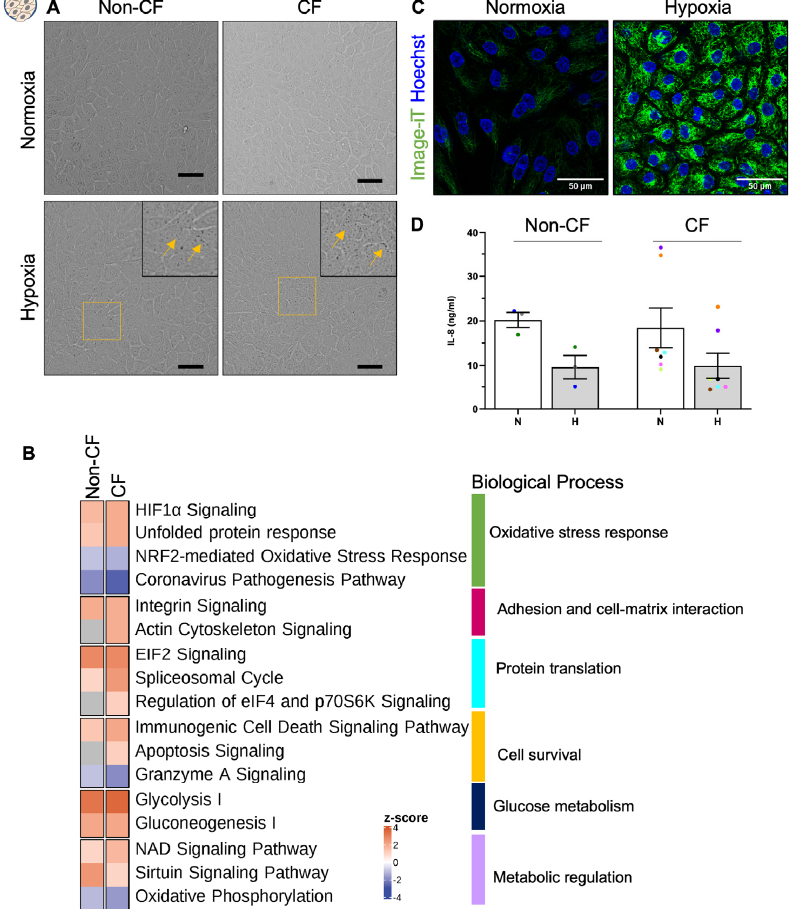
Figure 2. E ff ect of chronic hypoxia on the expansion of primary human nasal epithelial cells (hNECs). ( A ) Representative bright fi eld images of hNECs cultured at normoxia and hypoxia for 5–7 days. Magni fi ed inset with yellow arrows shows granulation. Scale bars = 50 µm. ( B ) Heatmap of enriched canonical pathways of di ff erentially expressed proteins determined by IPA. Color indi- cates the z-score for each pathway, with red (positive) indicating predicted activation, blue (nega- tive) indicating predicted inhibition, and grey indicating no enrichment. Data were derived from 3 non–CF and 8 CF participants. ( C ) Representative intracellular hypoxia imaging using Image–iT green hypoxia reagent, 63x/1.4 oil immersion objective. Scale bars = 50 µm. ( D ) IL–8 ELISA meas- urement in culture supernatants of con fl uent normoxic and hypoxic hNECs. Each colored circle represents cultures of an individual participant. Data are presented as bar plots with mean ± stand- ard error of the mean (SEM). One-way ANOVA was used to determine statistical signi fi cance. Next, we investigated cellular response to hypoxia by assessing alteration to the global proteome of basal stem cells when cultured at hypoxia compared to those at normoxia. Over 2000 proteins were identi fi ed in all samples using label-free LC-MS/MS. Robust, global proteomic responses to alteration of culture oxygen level were observed in both non-CF and CF samples. Volcano plots in Figure S1B show the number of Di ff eren- tially Expressed Proteins (DEPs). The commonly upregulated proteins in the cells cultured under hypoxic conditions include hypoxia-inducible protein N-myc downstream-regu- lated gene 1 (NDRG1), mesenchymal cell marker vimentin (VIM), an enzyme for collagen synthesis (P4HA1, P4HA2) and glucose transporter (SLC2A1) (Figure S1B, Table S1). The common downregulated proteins included glutamine synthase enzyme (GLUL),